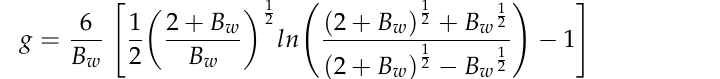
Figure 3. Intrinsic viscosity of LPBS ( □ ) and BPBS ( ◇ ) and 𝑔 (cid:4593) the viscosity branching index ( ○ ), dotted line representing Mark Houwink Sakurada (MHS) semi-logarithmic line.